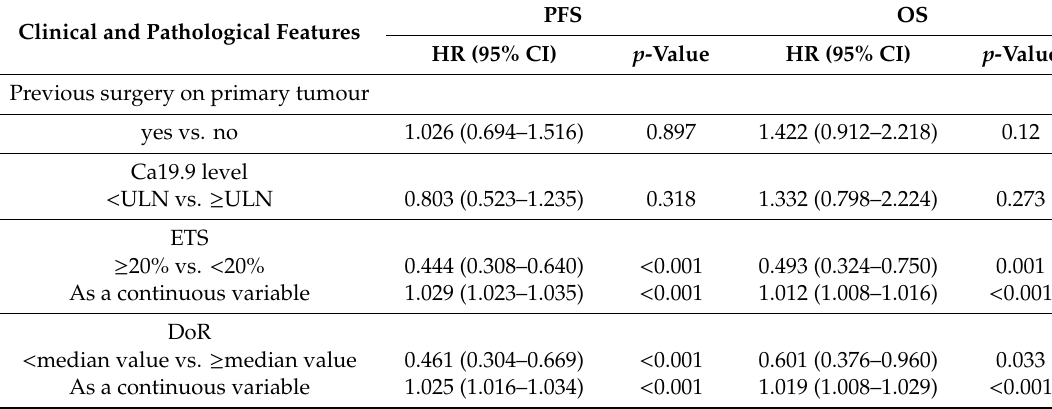
Table 4. Median OS and PFS with respect to ETS and DoR in the two treatment groups. PFS and OS in Treatment Groups